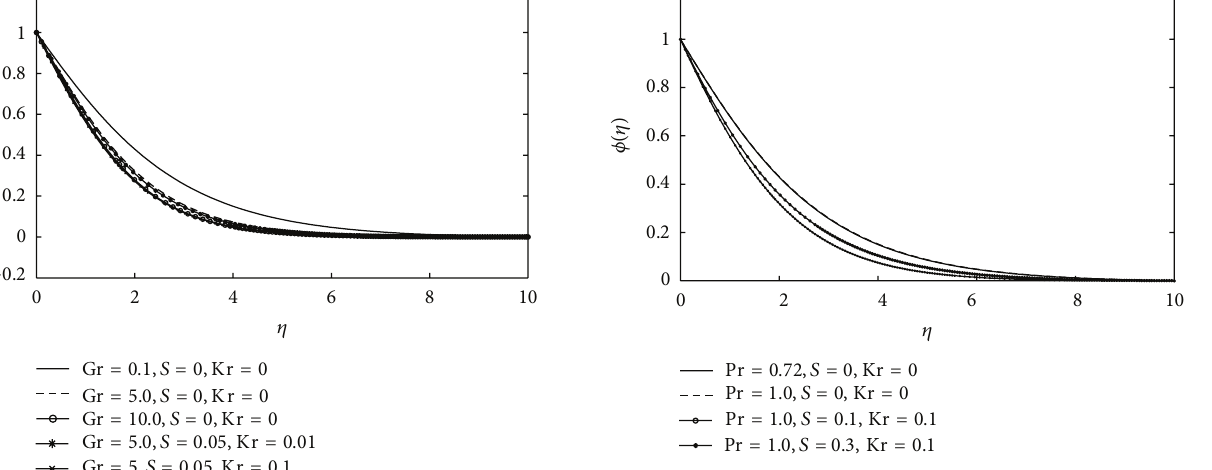
Figure 19: Concentration profiles for different values of Pr, 𝑆 , and Kr for Ha = 0.1 , Gr = 0.1 , Gc = 0.1 , Sc = 0.62 , Bi = 0.1 , Nc = 0.01